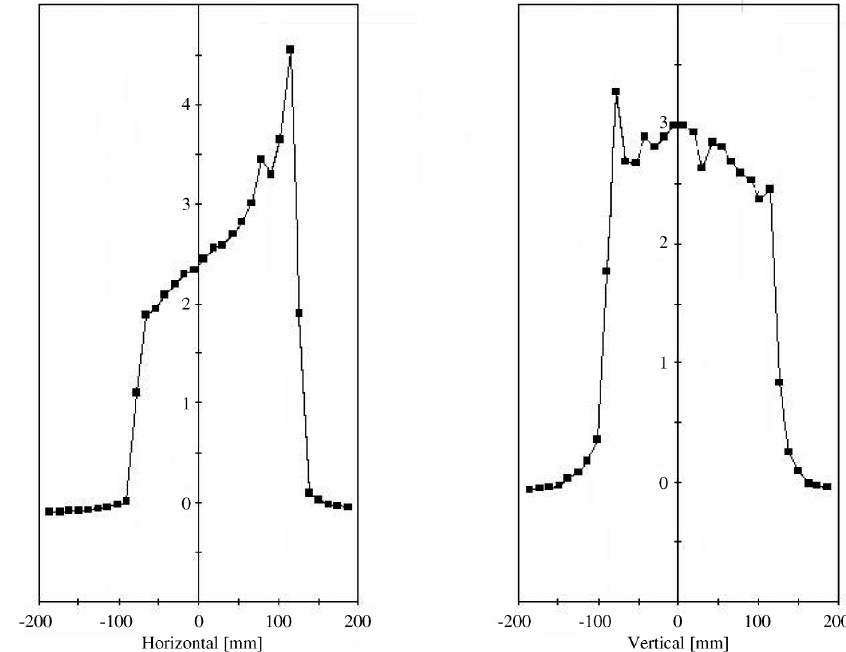
FIG. 8. Measured, horizontal and vertical projections of the beam’s distribution at the target location with the octupoles ON. These beam profiles were generated by displacing horizontally, at octupole O1, the beam’s axis by 5 mm with respect to the axis of the